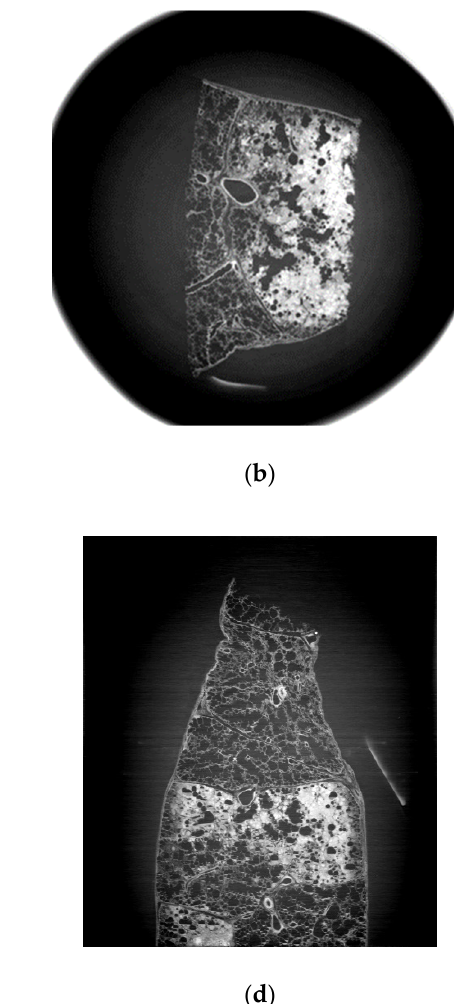
Figure 2. Synchrotron radiation (SR) tomographic images of human normal lung tissue. ( a ) Cross-sectional image of human normal lung tissue. Alveolar spaces, interalveolar septa, bronchioles and microvascular structure are clearly defined. ( b ) Images of normal lung tissue containing hemorrhagic areas inside. They are presented as gray to whitish spots packed in alveolar spaces. Surrounding interstitium was not deformed or thickened. Inherent alveolar structures including microvasculature, interalveolar septa and bronchioles were preserved. ( c ) Sagittal images of normal lung tissue without hemorrhage. ( d ) Sagittal images of normal lung tissue with hemorrhage.